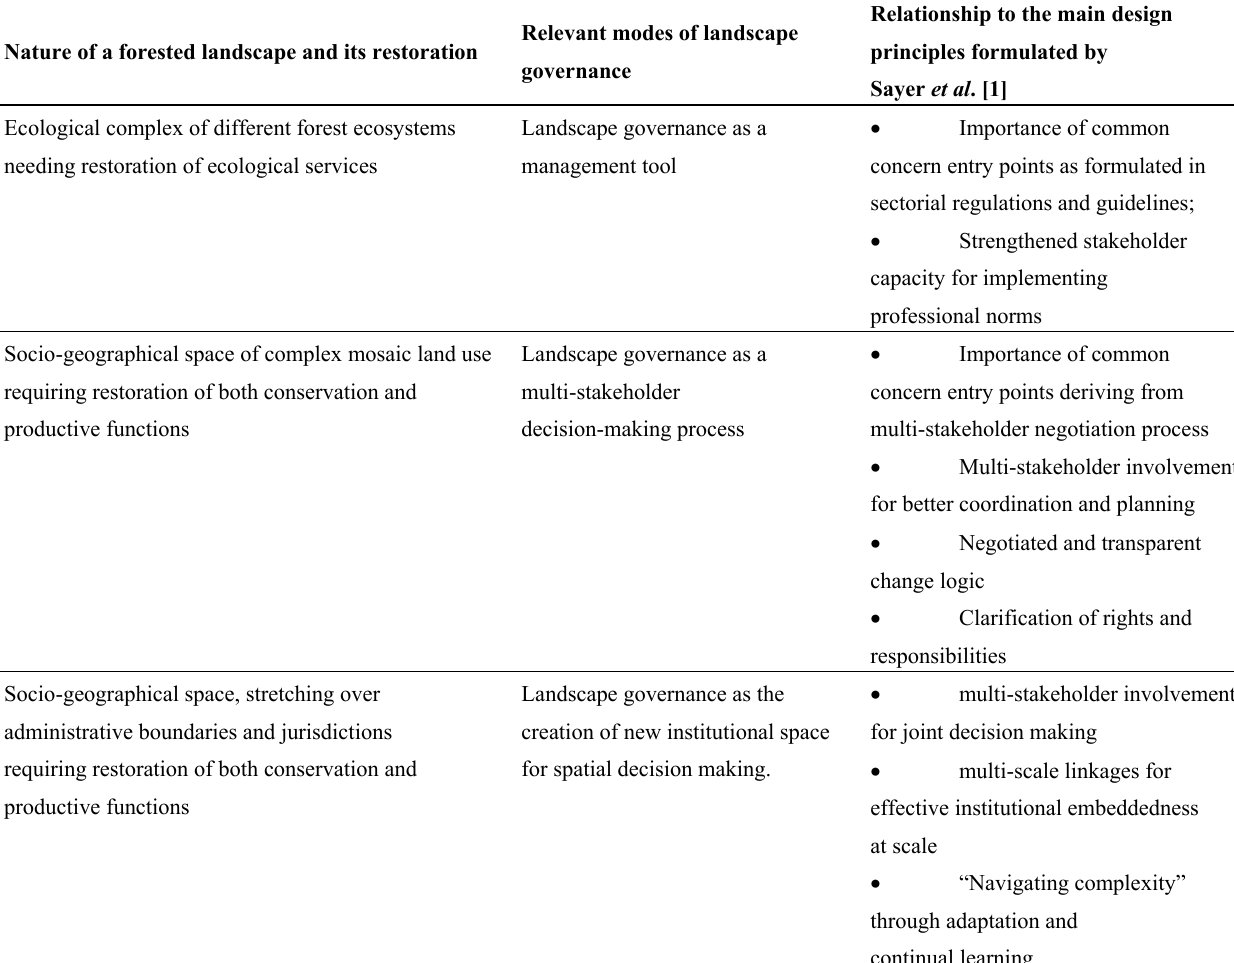
Table 1. Analytical framework for assessing different interpretations of forest landscape restoration and landscape